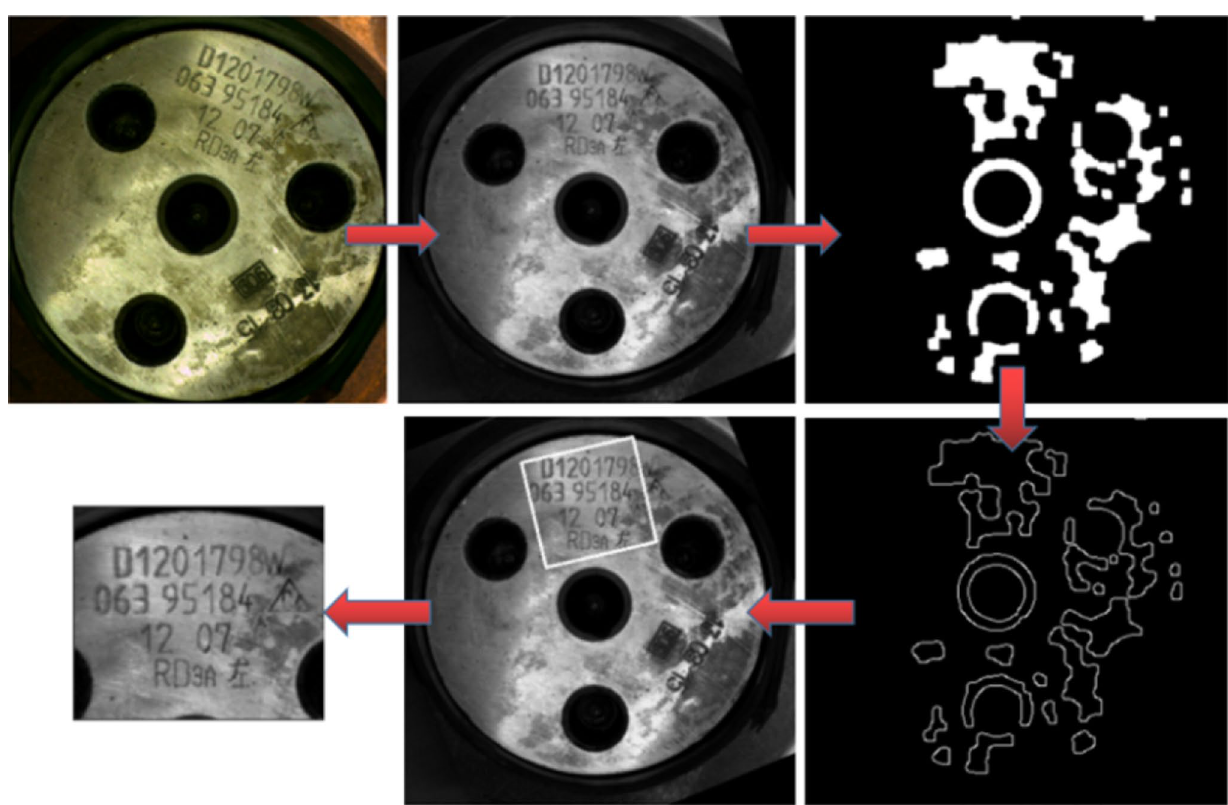
Fig. 15 Target region segmentation